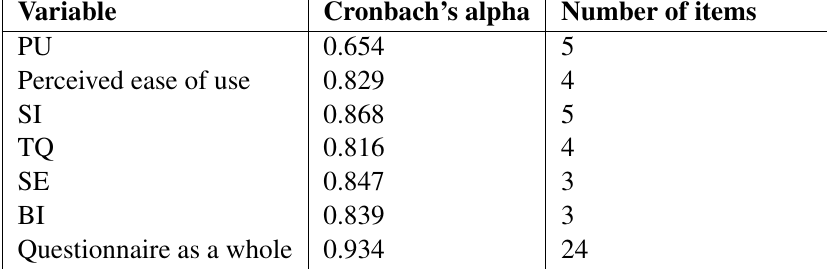
Table 7 Results of the reliability analysis of the test questionnaire